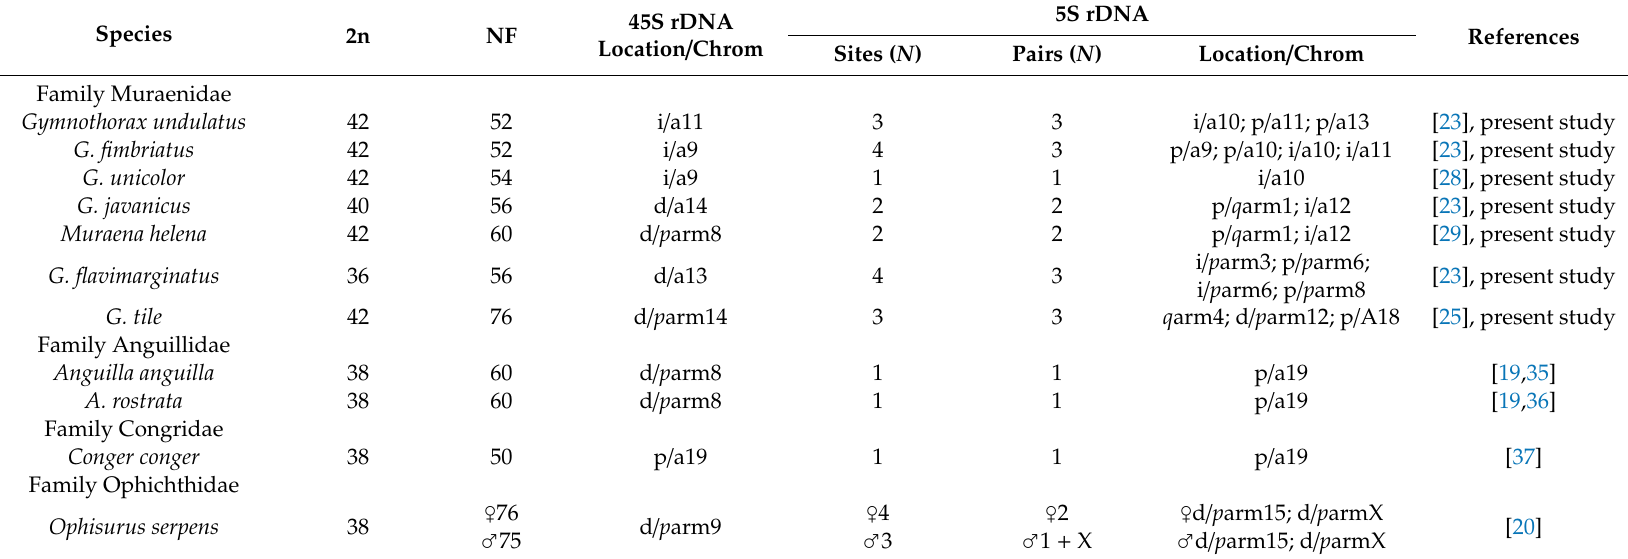
Table 1. Chromosomal pattern of ribosomal genes in Anguilliformes; 2n (diploid chromosome number), NF (fundamental arm number), sites ( N number of sites), pairs ( N number of chromosome bearing pairs), location: i (interstitial), d (distal), p (proximal), chrom: chromosome pair, a (acrocentric), p arm (short chromomomal arm), q arm (long chromosomal arm). Each species has a single locus for 45S